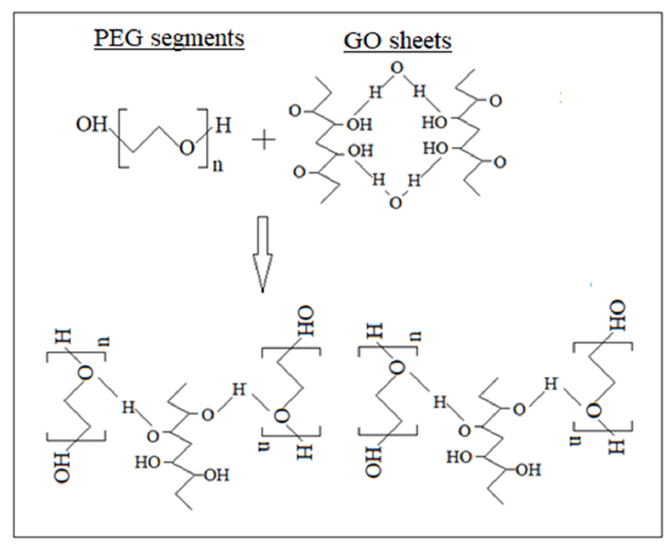
Figure 11. Schematic representation of the Bridging effect.